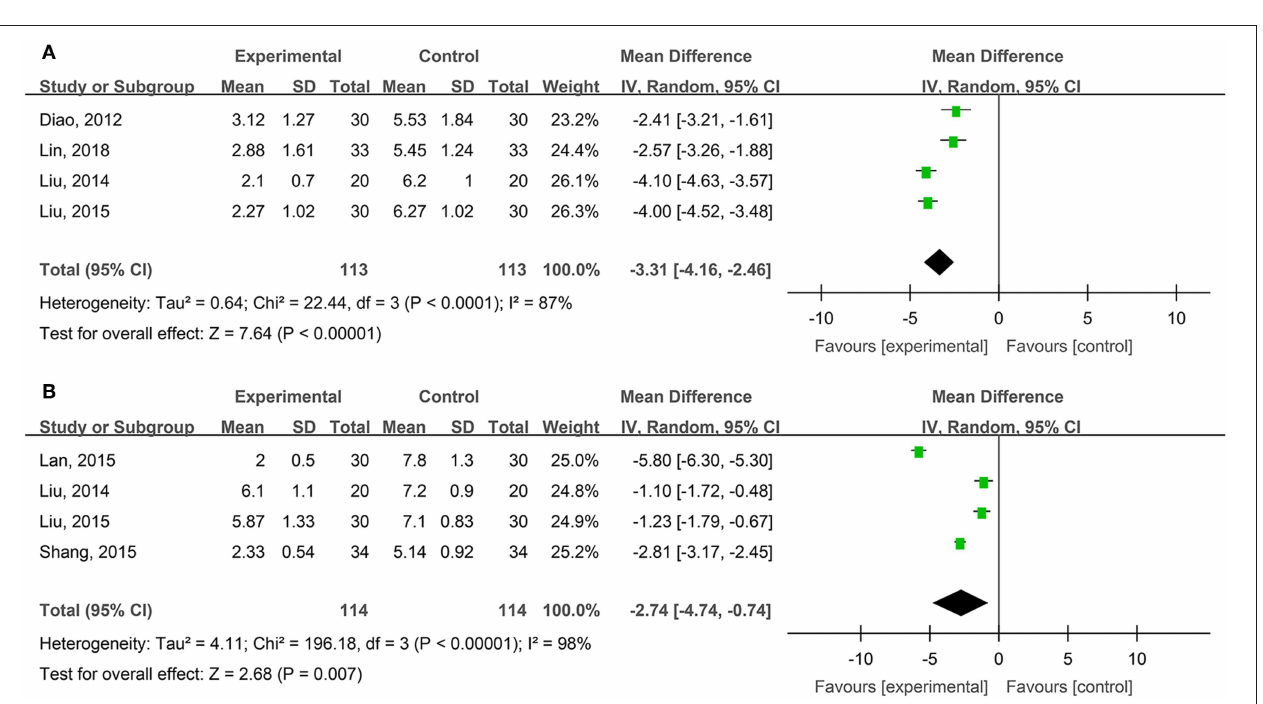
FIGURE 4 | Comparative meta-analysis of VAS pain scores of degree-II superficial (A) and deep (B) burn